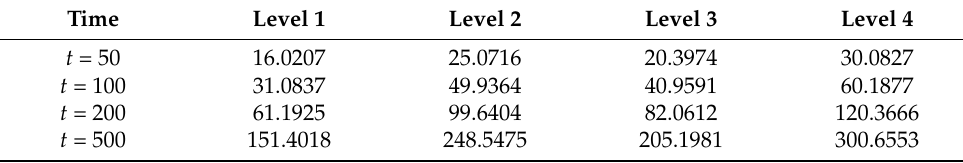
Table 5. Expected number of visits up to a certain time for different